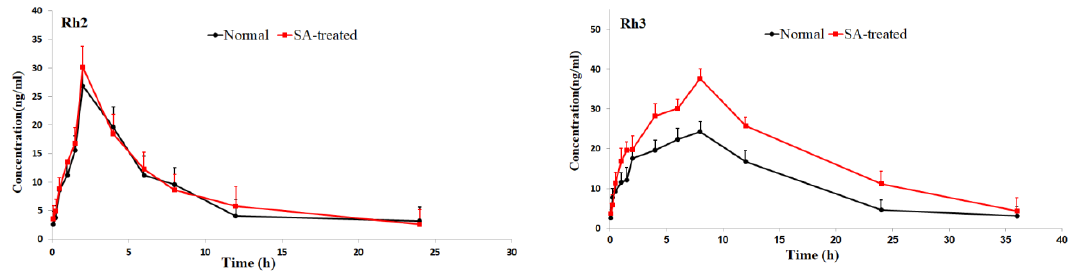
Figure 3. Mean plasma concentration-time profiles of the 16 ginsenosides in normal and scopolamine-treated rats following oral administration of RGS at a single dose of 100 mg/kg.